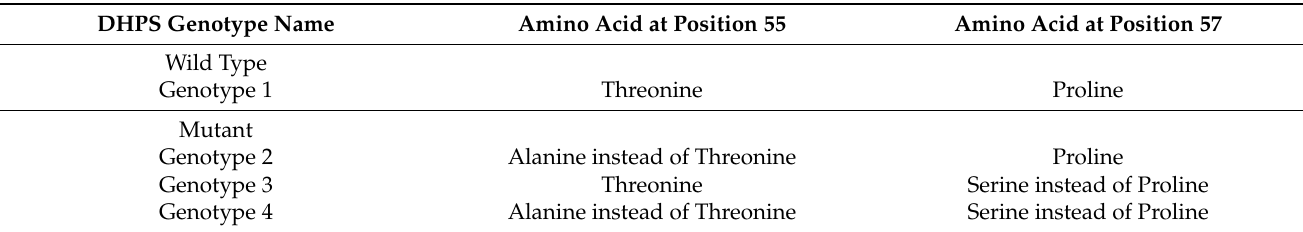
Table 1. Commonly reported amino acid substitutions observed in the DHPS gene of Pneumocystis jirovecii . DHPS Genotype Name